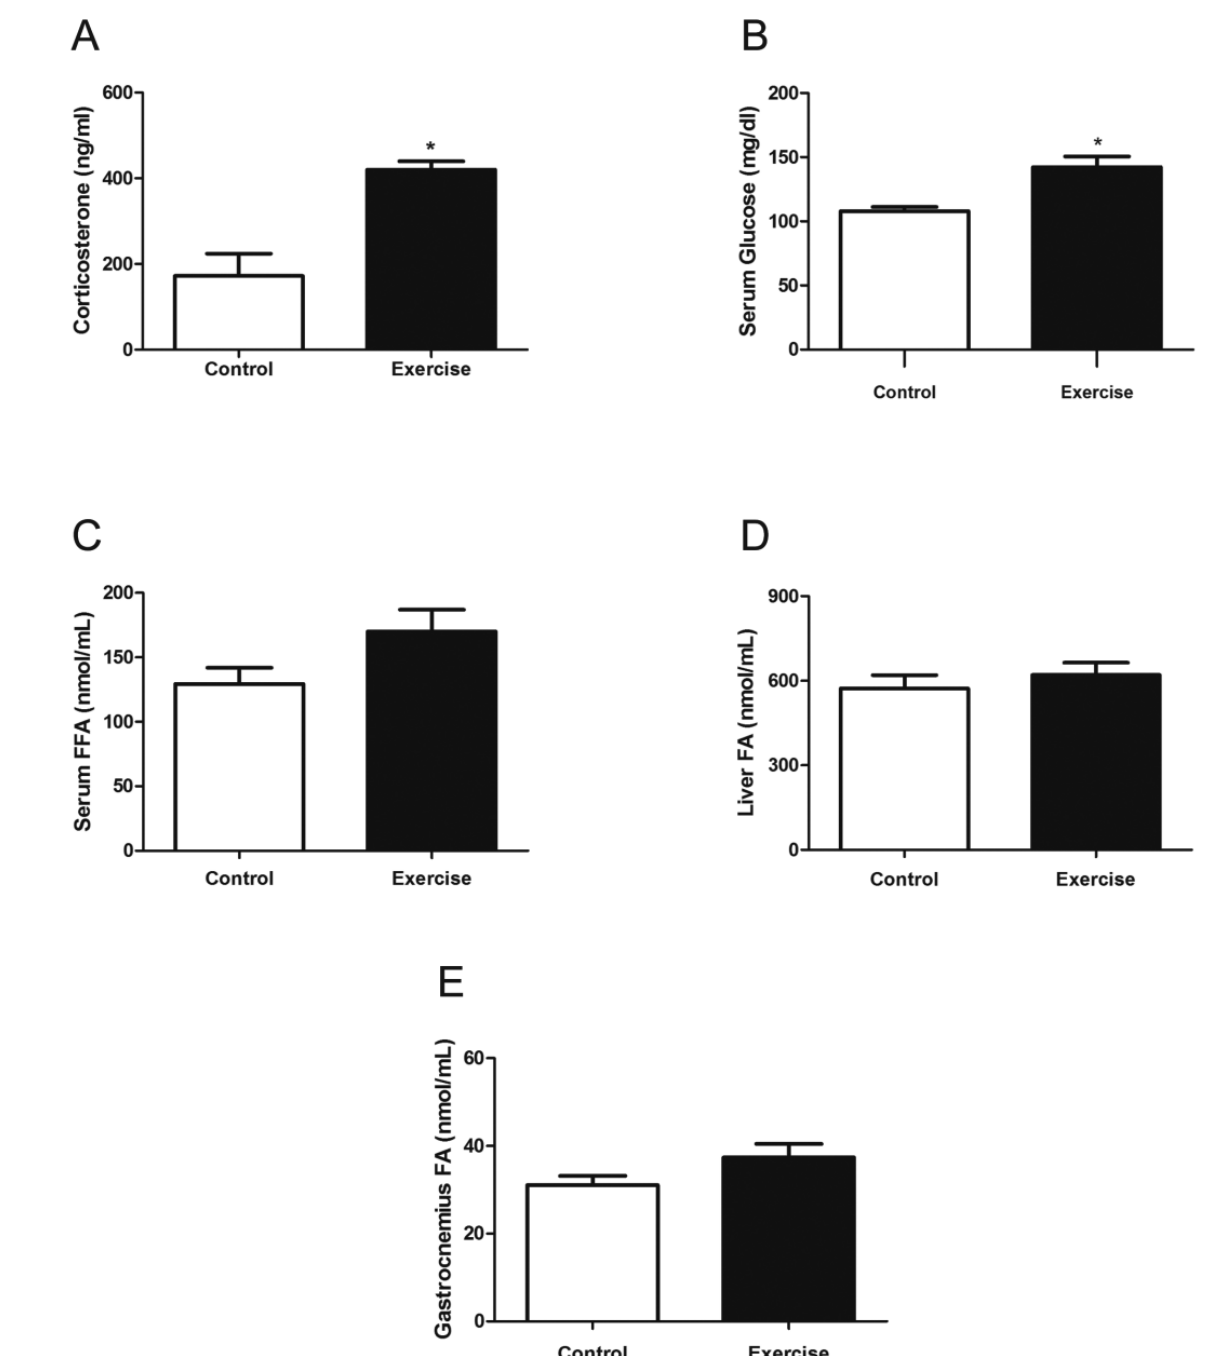
Figure 2. (A) Serum corticosterone concentrations after a single exhaustive resistance exercise session. (B) Serum glucose concentrations after an exercise session. (C) Serum free fatty acid (FFA) concentrations after an exercise session. (D) Liver fatty acid (FA) content after an exercise session. (E) Gastrocnemius FA content after an exercise session. Each bar represents the mean ± SEM of rats. * different from Control group; P <